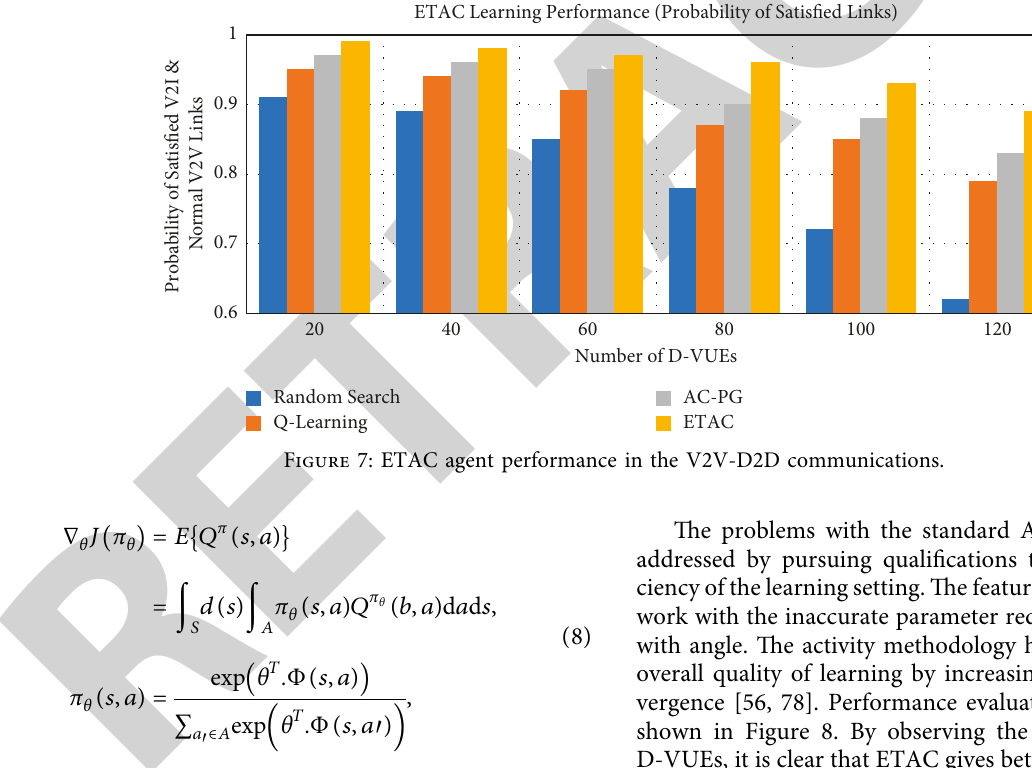
Figure 6: Network lifetime evaluation based on deep reinforcement agent scheduling